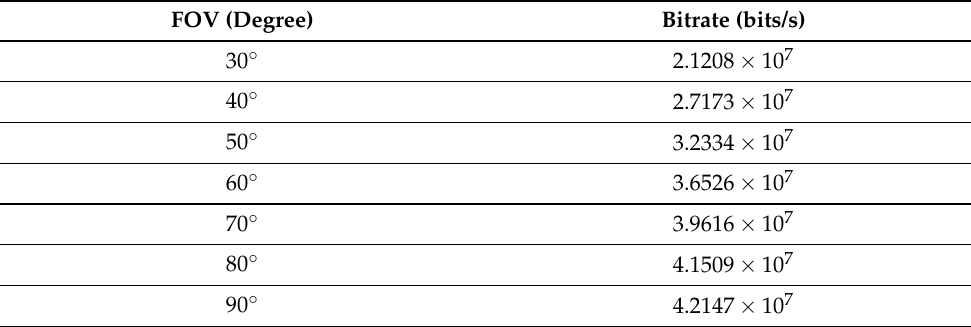
Table 3. Effect of FOV on the